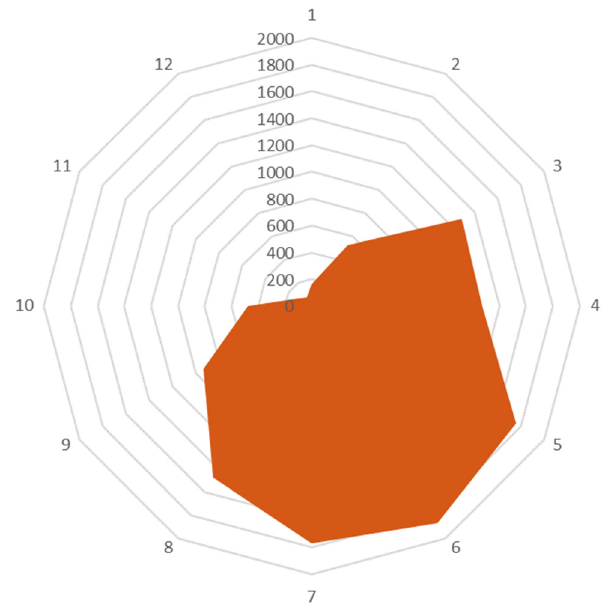
Figure 4. Average monthly production of electricity [kWh ∙ month − 1 ] during the year.